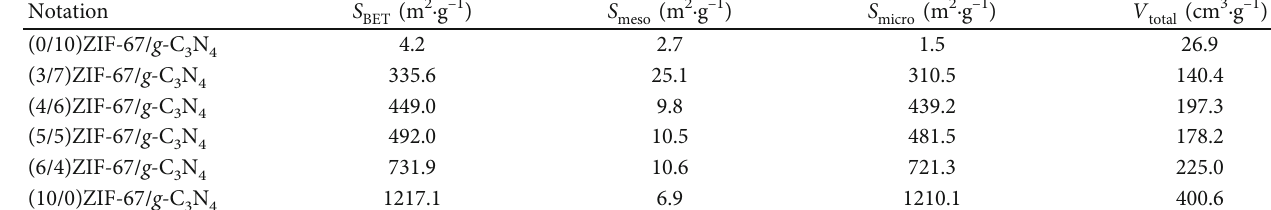
N , and ZIF-67/ g -C 3 4 N . 3 4